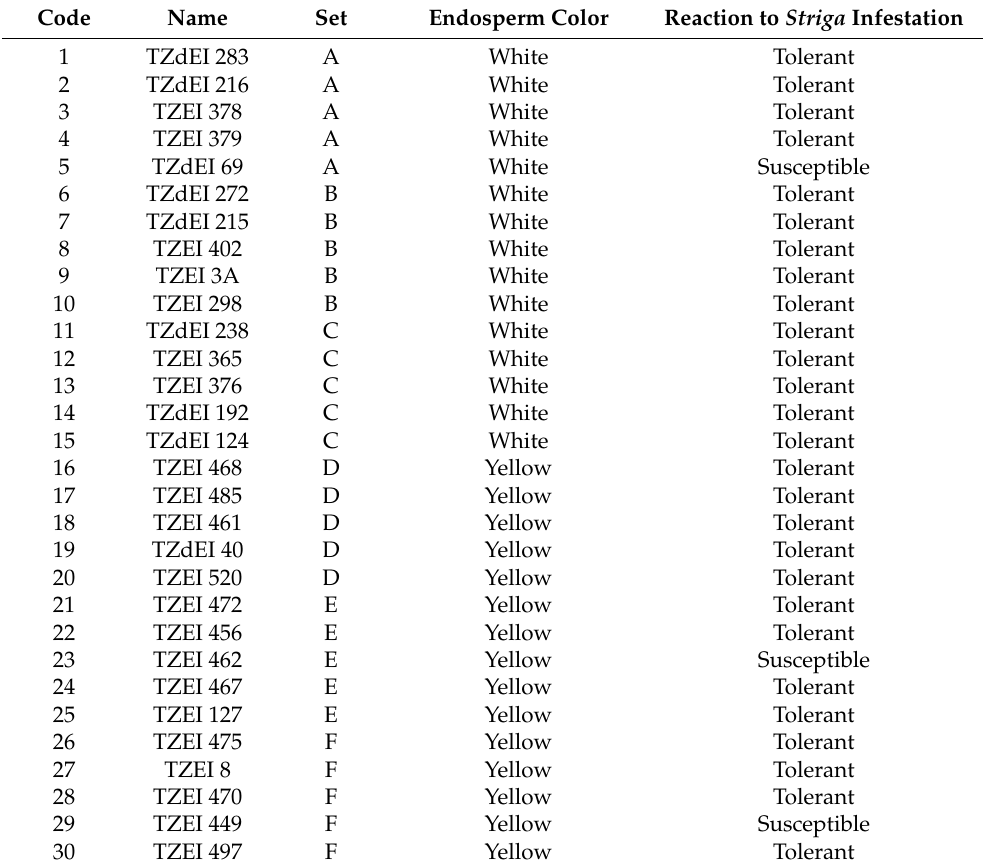
Table 1. Description of 30 early maturing maize inbred lines used in North Carolina Design II crosses. Code